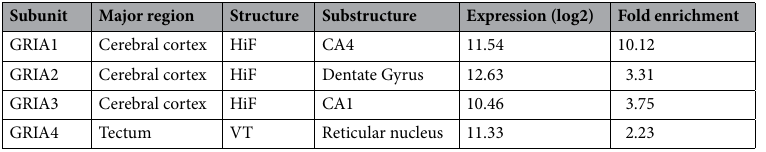
Table 1. Human brain substructures with greatest anatomical enrichment. The expression (log2) represents the average per brain region. The fold enrichment is the substructure’s value divided by the global average. HiF Hippocampal Formation, VT ventral